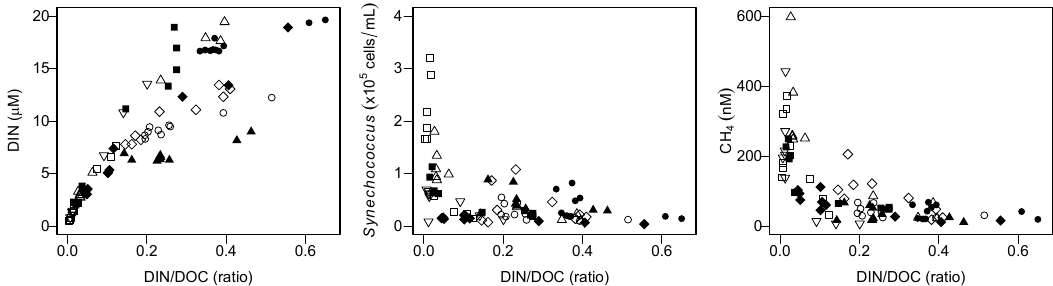
Figure 9. Effects of the stoichiometric balance between DIN and DOC on nitrogen availability, Synechococcus density and dissolved CH 4 concentration in the study lakes. See the legend for Figure 2 for a description of the symbols.